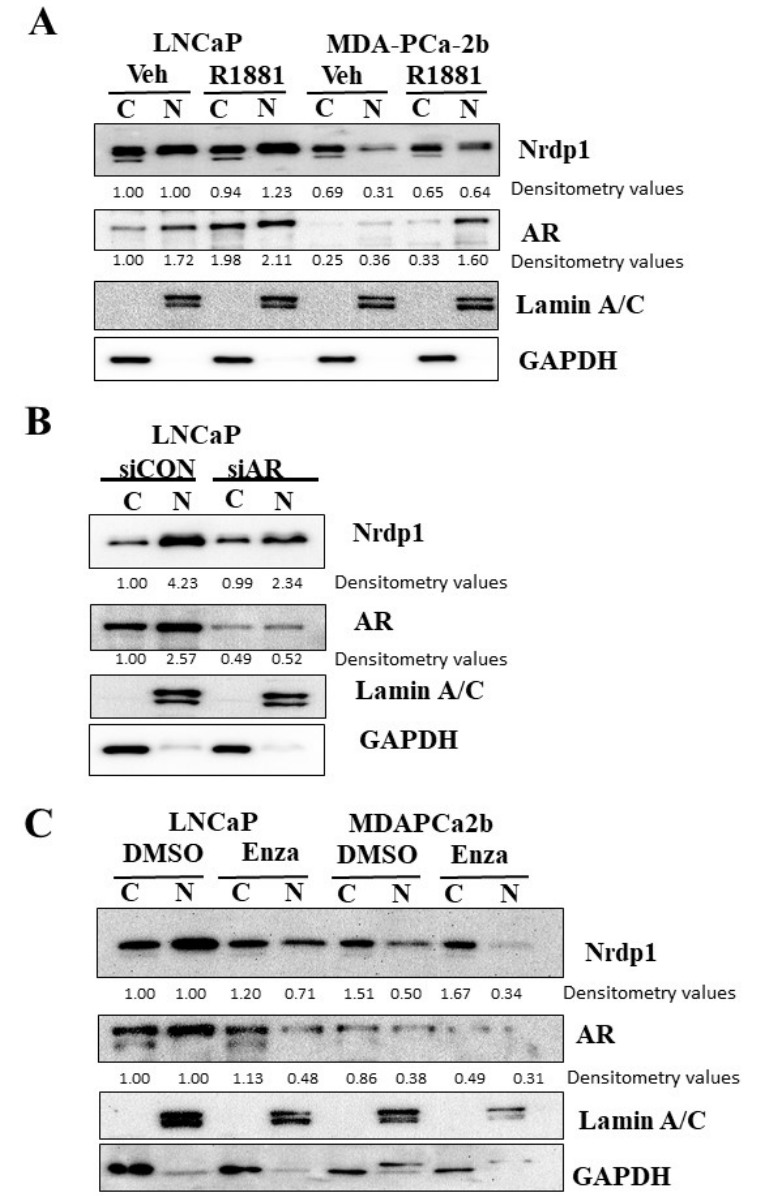
Figure 3. Transport of NRDP1 into the nucleus is associated with nuclear transport of the androgen receptor. Treatment of LNCaP and MDA-Pca-2b cells with synthetic androgen, R1881 (1 nM for 48 h) caused an increase in levels of both nuclear androgen receptor (AR) and nuclear NRDP1 ( A ) Inhibition of AR expression levels (treatment with AR siRNA, 50 nM for 48 h) ( B ) or inhibition of AR activity and translocation (treatment with Enzalutamide, 10 µM for 24 h) ( C ) caused a decrease in nuclear AR levels and a concurrent decrease in nuclear NRDP1 levels ( B,C ) The combined data demonstrate there is a strong correlation between AR and NRDP1 nuclear expression and translocation in these two cell lines. Detailed information about Western Blot can be found at supplementary materials.